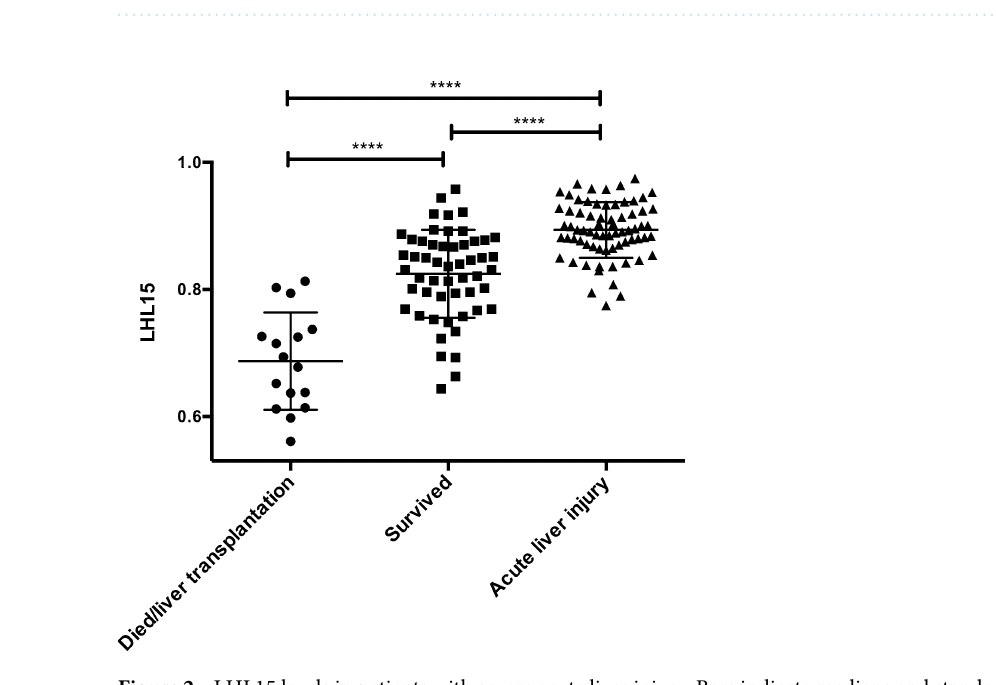
Table 1. Patient demographics. Data are presented as n (%) or median (interquartile range [IQR]). HBV hepatitis B virus, AST aspartate aminotransferase, ALT alanine aminotransferase, PT-INR prothrombin time- international normalized ratio, MELD model for end-stage liver disease, LHL15 hepatic accumulation index calculated by dividing the radioactivity of the liver regions of interest by that of the liver-plus-heart regions of interest at 15 min; HH15, blood clearance index calculated by dividing the radioactivity of the heart regions of interest at 15 min by that at 3 min.